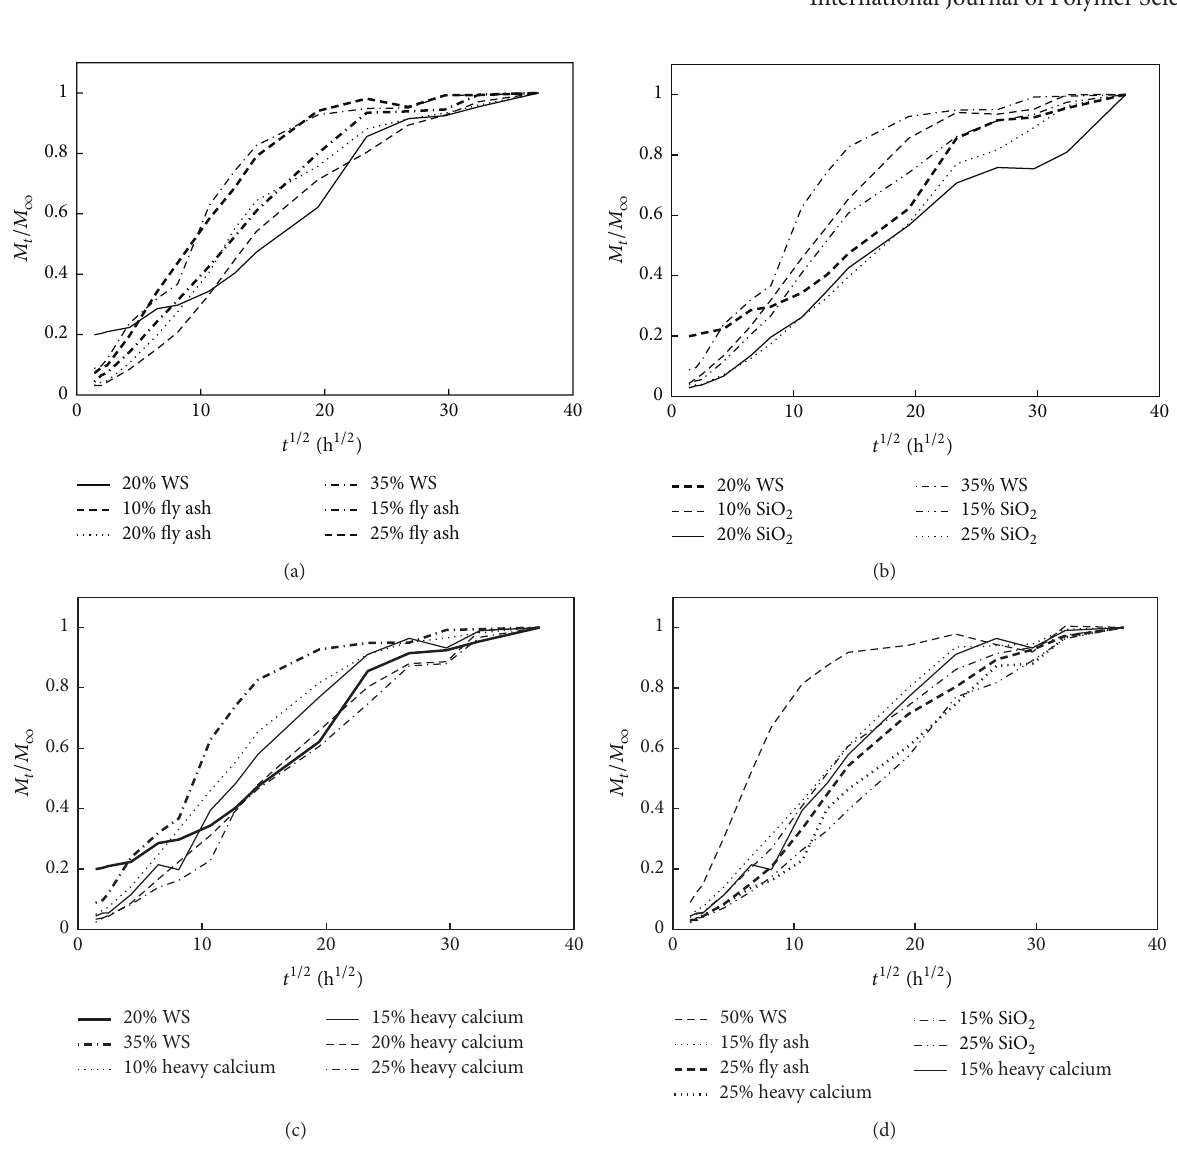
Figure 5: Curves of 𝑀 𝑡 /𝑀 ∞ versus 𝑡 1/2 of WS and inorganic filler reinforced PP